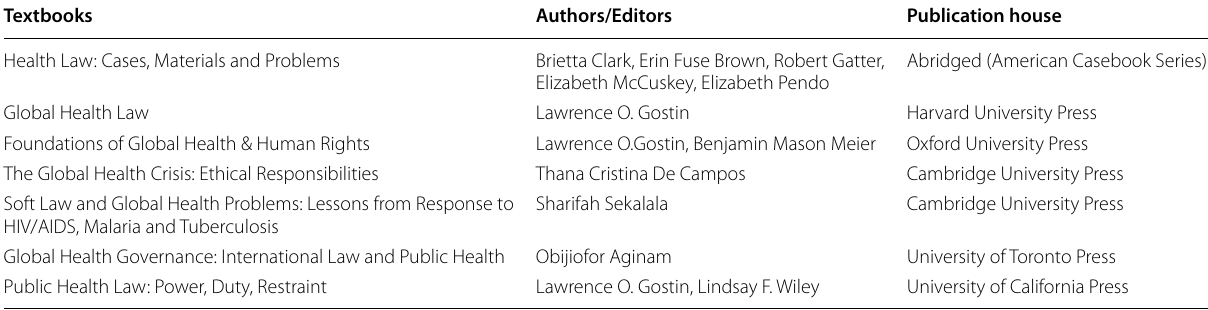
Table 2 Selected health law textbooks from Western countries